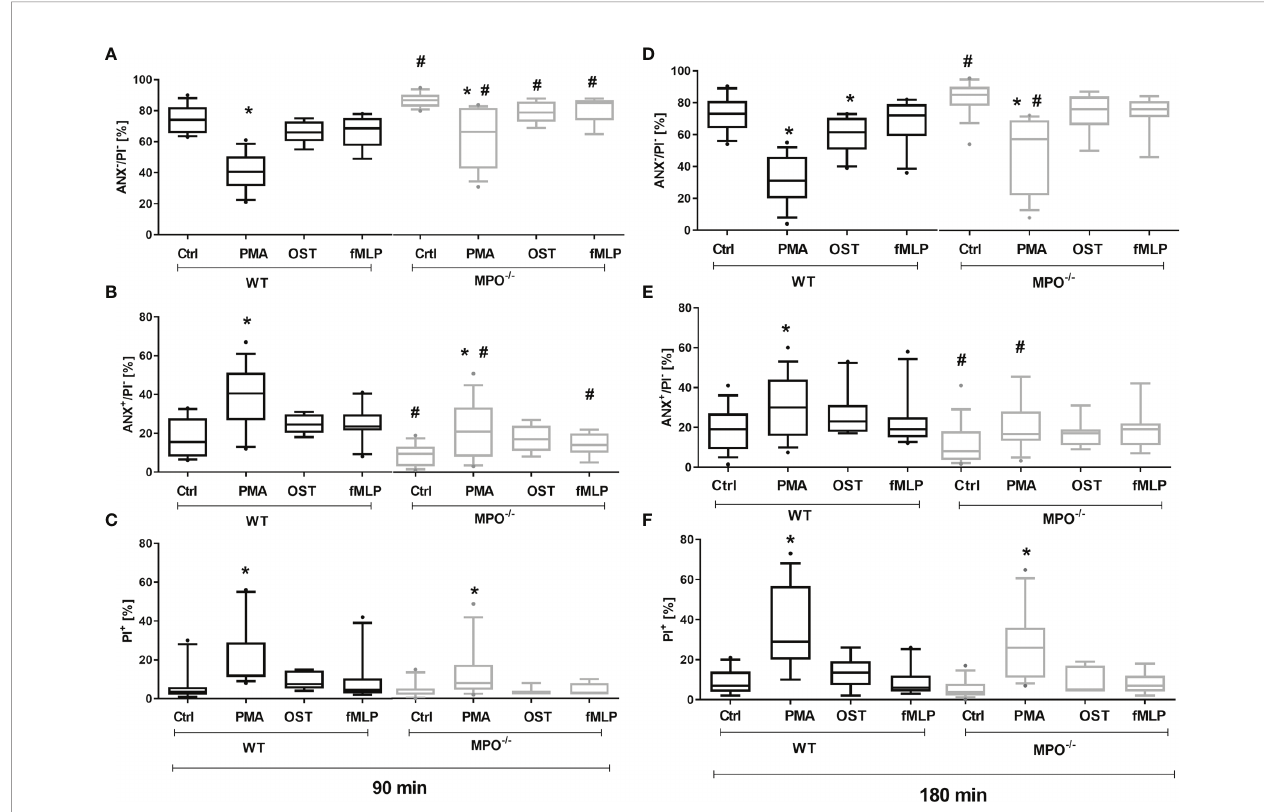
FIGURE 1 | Increased Annexin V + and cell death (PI + ) of PMNs isolated from in fl amed lungs of WT and MPO -/- mice after the induction of oxidative burst by PMA, OST, and fMLP for 90 min (A – C) and 180 min (D – F) . PMNs (3x 10 6 cells/ml) isolated from BALF of WT and MPO -/- mice were stimulated with PMA (80 nM), OST (1:10 MOI) and fMLP (1.14 m M) for 90 and 180 min. Next, cells were evaluated by fl ow cytometry and numbers of viable (ANX - /PI - ), Annexin V + (ANX + /PI - ), and dead cells (PI + , both ANX + /PI + and ANX - /PI + ) were determined. Data are presented as median, 25, and 75 percentiles (the box) and 10 and 90 percentiles (the whiskers), and values below and above the whiskers are drawn as individual dots, n = 7-14. *Shows statistically signi fi cant difference (p < 0.05) compared with untreated control (Ctrl). # shows statistically signi fi cant difference (p < 0.05) between MPO -/- (MPO-KO) and wild-type